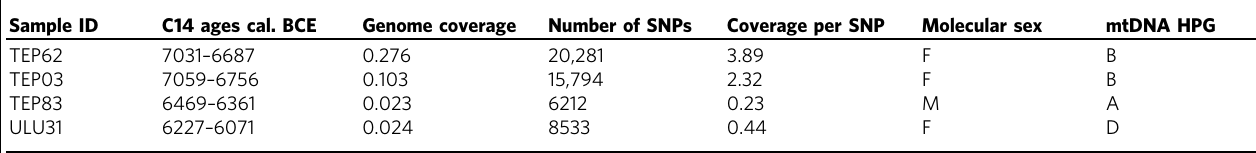
Table 1 High-throughput sequencing summary statistics, AMS C14 ages, molecular sex estimates, and mtDNA haplogroups (HPGs) of four ancient